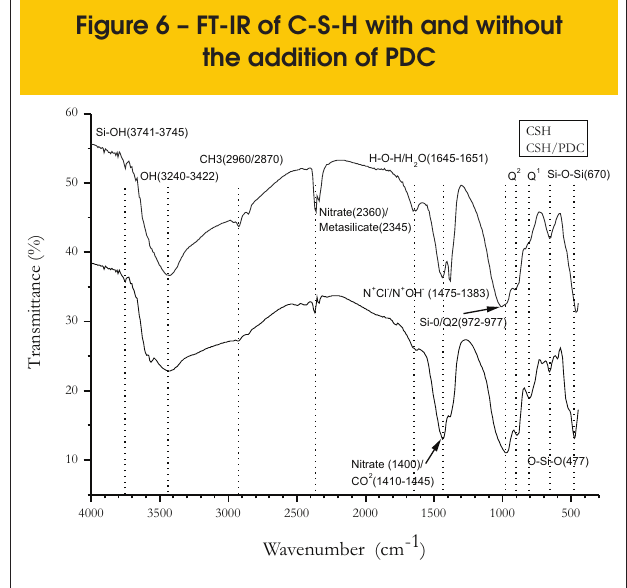
Figure 6 – FT-IR of C-S-H with and without the addition of PDC